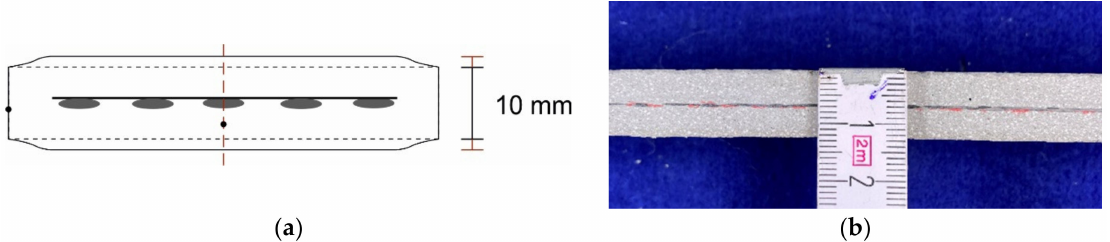
Figure 13. ( a ) Sketch of the cross-section—determination of dimensional accuracy; ( b ) Measurement cross-section carbon textile Mortar 2.